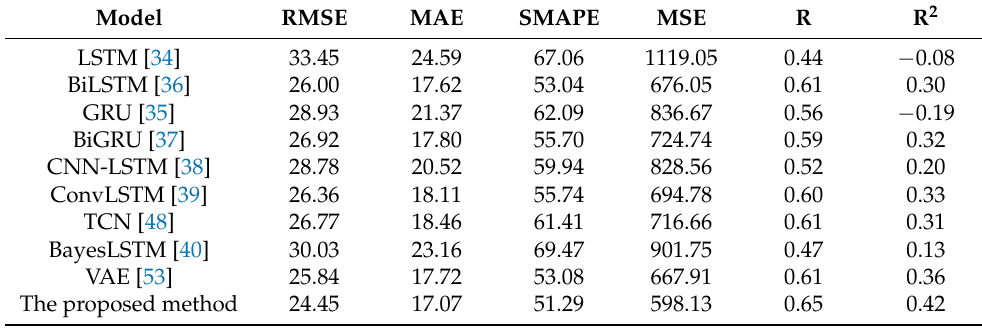
Table 1. Accuracy evaluation of prediction results of each model on the PM2.5 dataset.